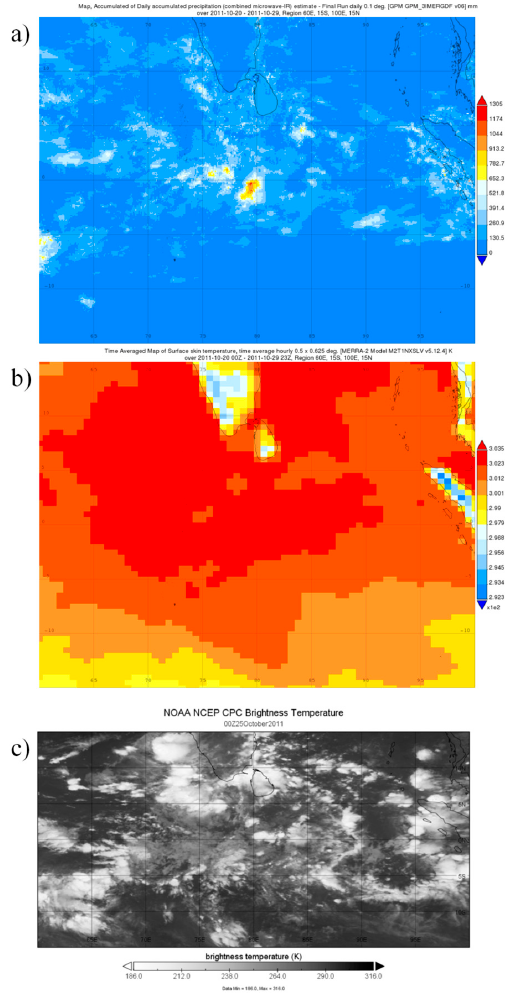
Figure 3. A Madden–Julian Oscillation event in October 2011. ( a ) Accumulated rainfall (in mm) from the half-hourly IMERG Final Run between 20 and 29 October 2011; ( b ) MERRA-2 average surface skin temperature (in Kelvin); and ( c ) a snapshot of the IR brightness temperature (in Kelvin) from the NOAA NCEP CPC merged IR dataset at 00Z 25 October 2011.